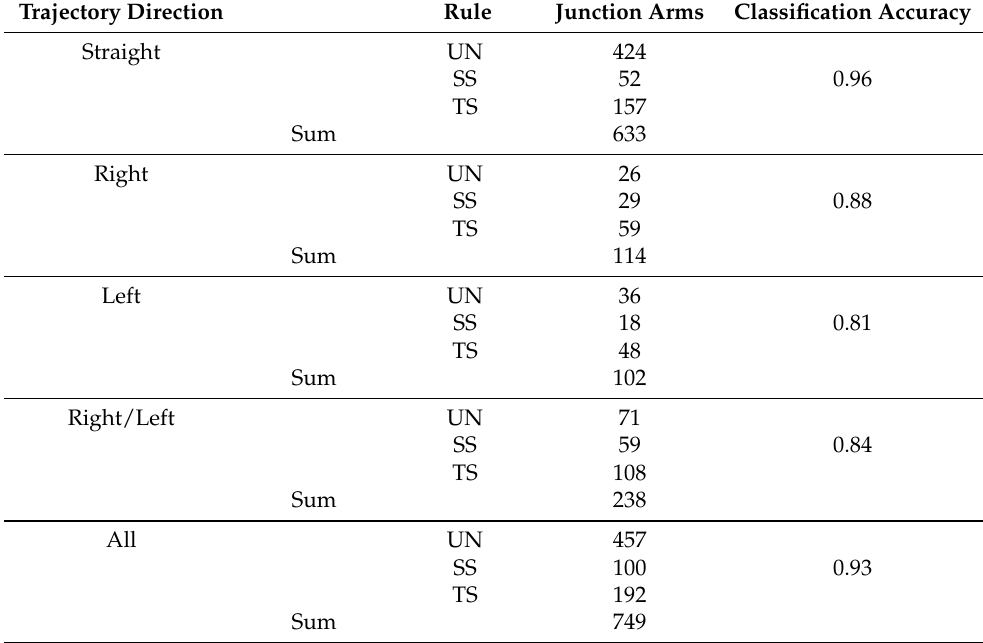
Table 7. Dataset size for different trajectory direction settings with minimum number of trajectories per junction arm equal to 5 (Champaign dataset).